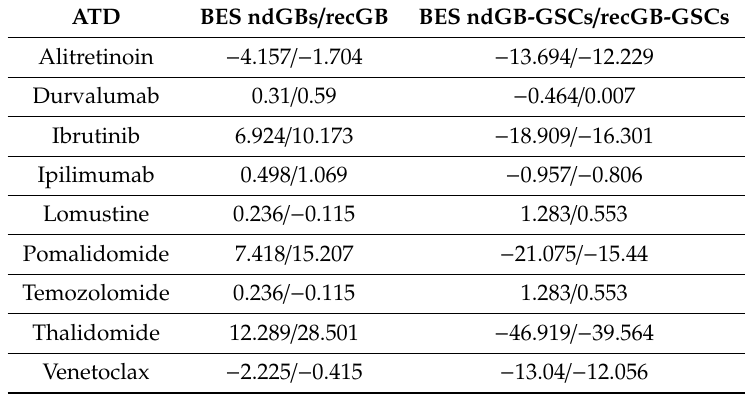
Table 1. Anticancer target drugs (ATDs) showing di ff erential (AUC ≥ 0.7) ranking in ndGB vs. recGB comparisons in both tissue-based and GSC-based RNA sequencing